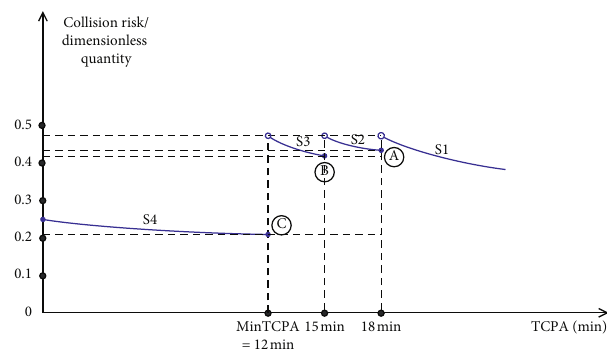
Figure 15: Distribution of early warning and risk estimation of ship-ship collision. A: understanding each other’s movements. B: unifying collision-avoidance strategies. C: taking coordinated maneuvering actions. S1: not yet understanding each other’s movements. S2: not yet unifying collision-avoidance strategies. S3: not yet taking coordinated maneuvering actions. S4: verifying collision-avoidance effectiveness. TCPA: time to the closest point of